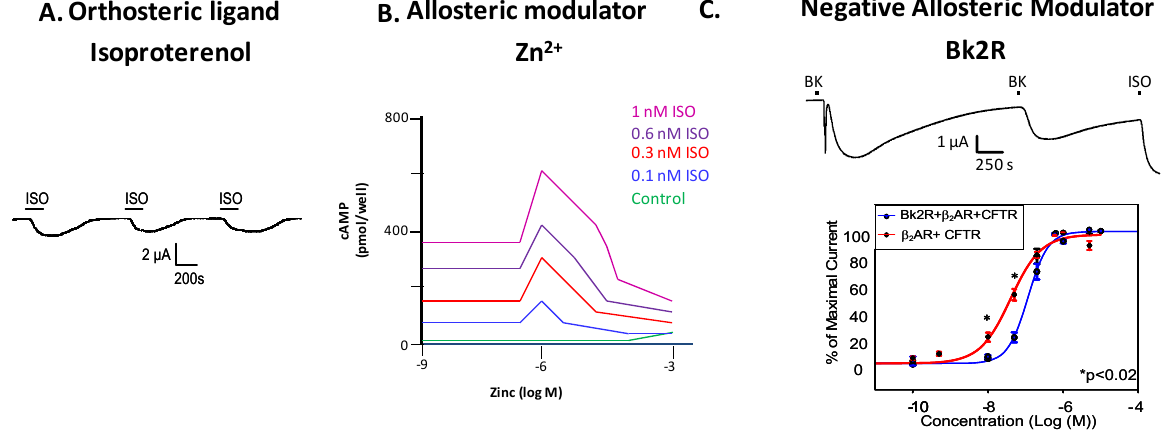
Figure 2. Modulators of β AR. ( A ). Stimulation with isoproterenol (ISO) leads to activation of 2 the cognate signaling pathway; ( B ). Increasing concentrations of Zn 2+ initially have a positive allosteric effect on ISO-mediated activation of β AR, which then becomes inhibitory [7]; 2 ( C ). B2R is a negative allosteric modulator of β AR, as it is able to activate β AR on its own 2 2 (top), while having a negative allosteric effect on β AR cognate signaling in response to the 2 selective agonist terbutaline (bottom). Data in parts A and C are from [7]. Negative Allosteric Modulator Bk2RB.